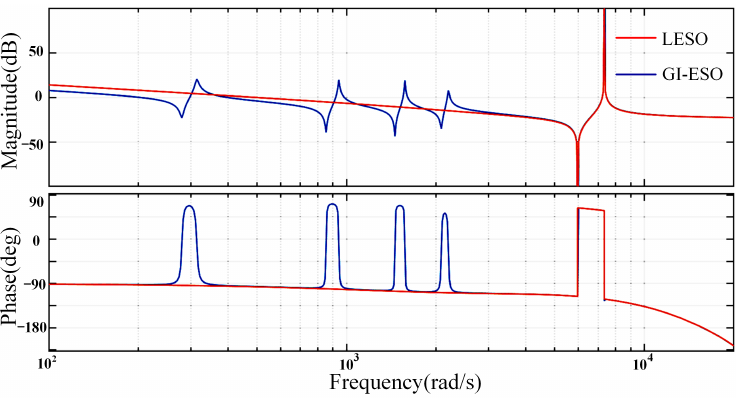
Figure 6. Bode diagrams of open-loop transfer functions for GI-ESO and LESO.